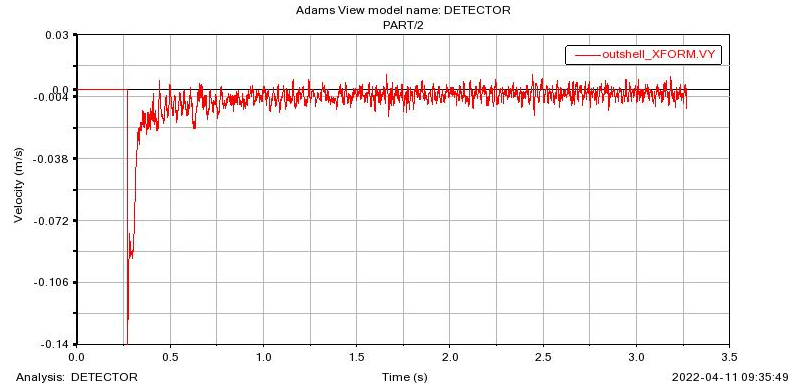
Figure 14. Variation curves of the velocity in Experiment 1 at different times.